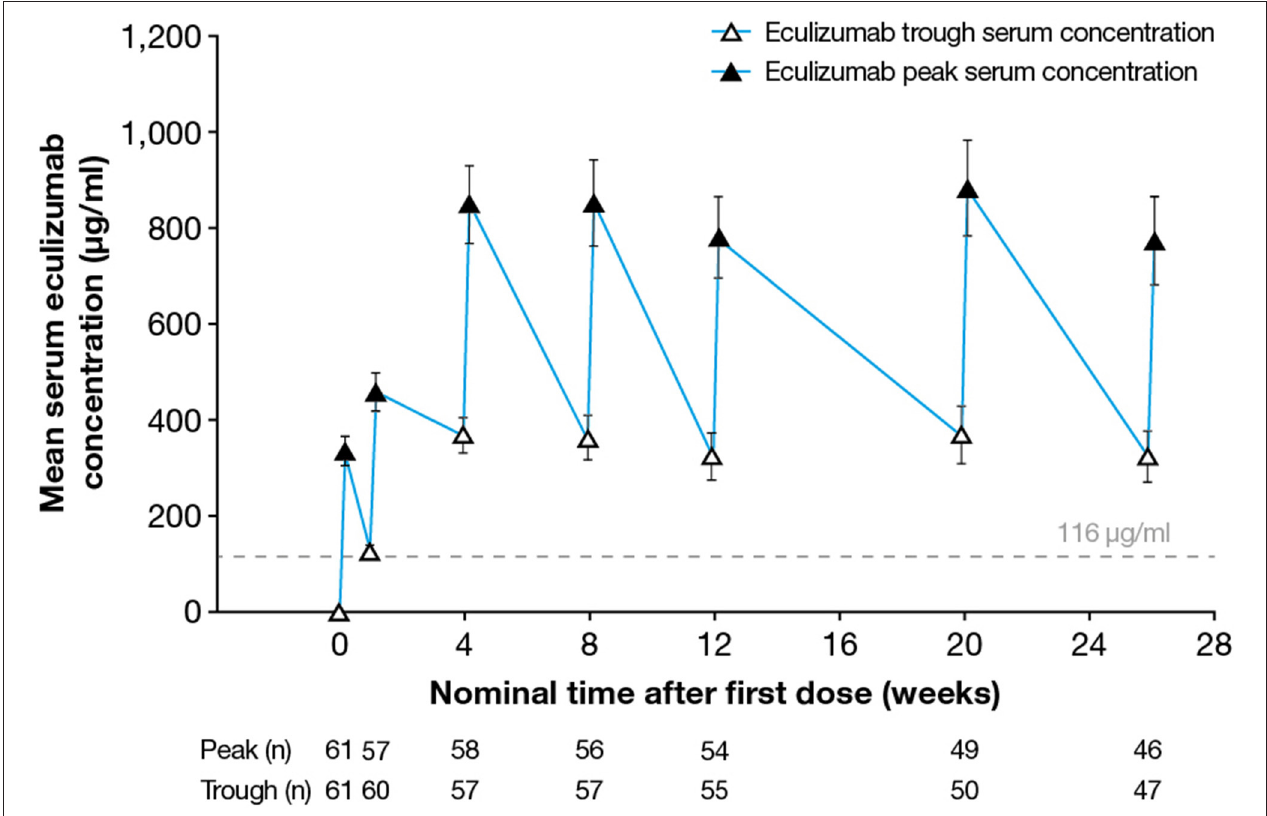
FIGURE 1 | Serum eculizumab concentrations during the study. Mean (95% CI) trough and peak serum eculizumab concentrations in patients who received eculizumab in the REGAIN study; eculizumab concentrations below the lower limit of quantification (9.38 µ g/ml) were analyzed as 0 µ g/ml. Eculizumab concentrations above 116 µ g/ml (dashed line) indicate sufficient concentration to achieve complete complement inhibition (see Figure 3 ). CI, confidence